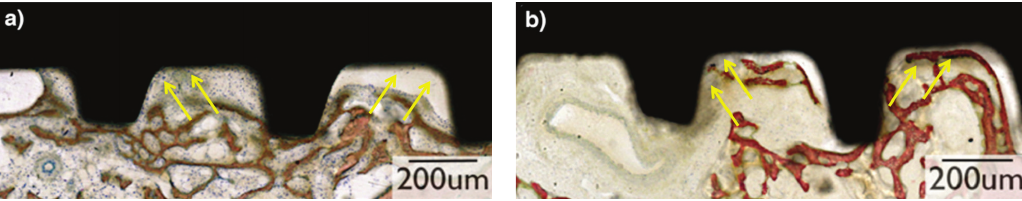
F 3: Representative overview of the histological micrographs of the plateaus at 2-week experimental period. (a) e histologic sections of the N�RBM group although presented layers of early connective tissue (stroma) �lling the region between plateaus (arrows), there are some areas that the stroma collapsed (arrows). (b) e histologic sections of the Plasma 30 days group showed initial signs of bone formation ad�acent to the implant surface (arrows) and the presence of layers of early connective tissue (stroma) �lling the region between plateaus without detachment of the surface